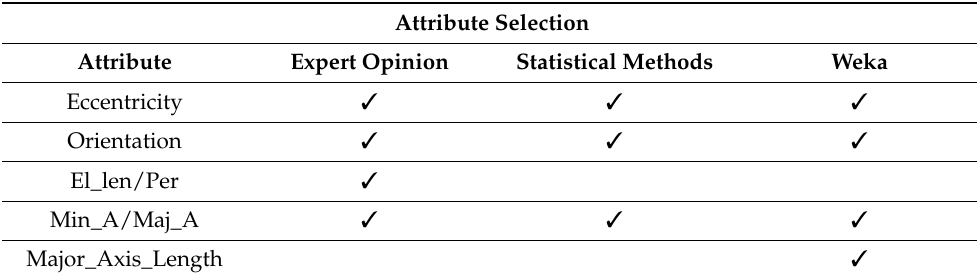
Table 4. Attributes selected for the analysis of rolled strip defects that belong to “attritions”, “scratches”, “lines”